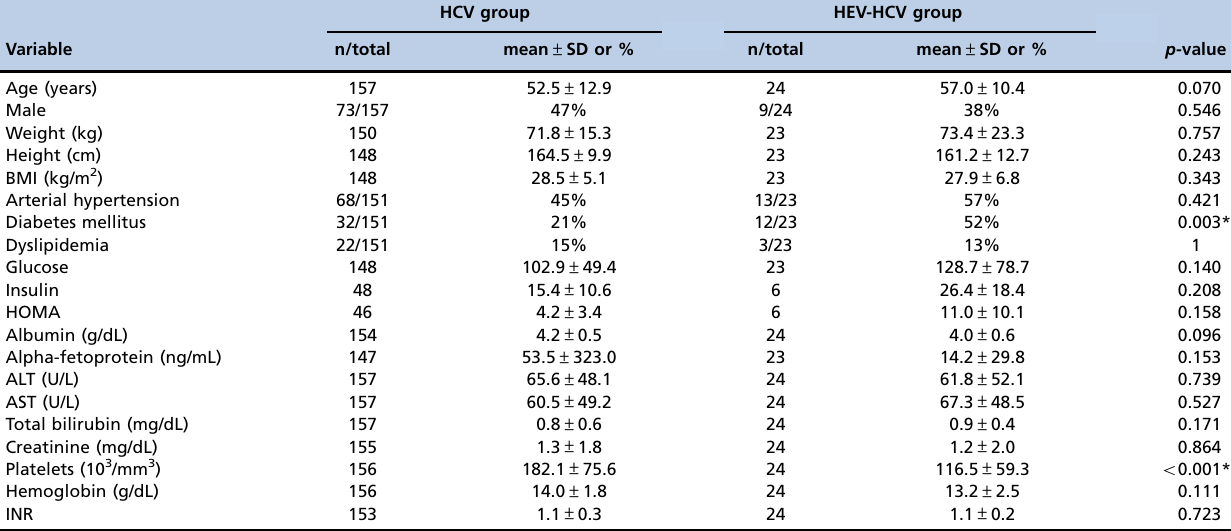
Table 2 - Demographic, clinical and laboratorial exams characteristics of patients with anti-HEV-positive and -negative antibodies.